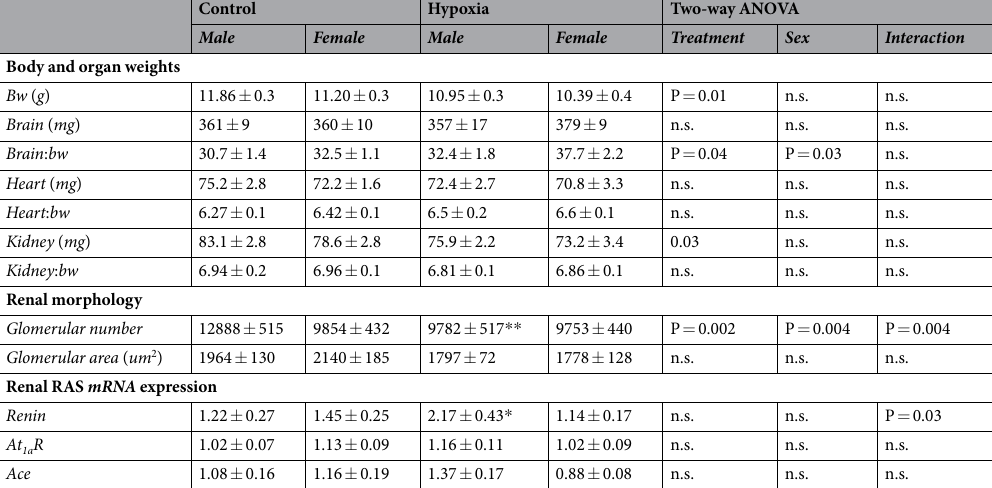
Table 1. Offspring body/organ weights, renal morphology and renal RAS mRNA expression at postnatal day 21. Values are mean ± SEM. Organ/body weight (bw): N = 2 offspring from 11 litters/group. Glomerular number/area: N = 8–9/group. mRNA expression: N = 9–12/sex/litter. Effect of treatment, sex or interaction (treatment x sex) was evaluated by two-way ANOVA. * P < 0.05, ** P < 0.001 comparing male control/hypoxia offspring with a Sidak post hoc . Not significant